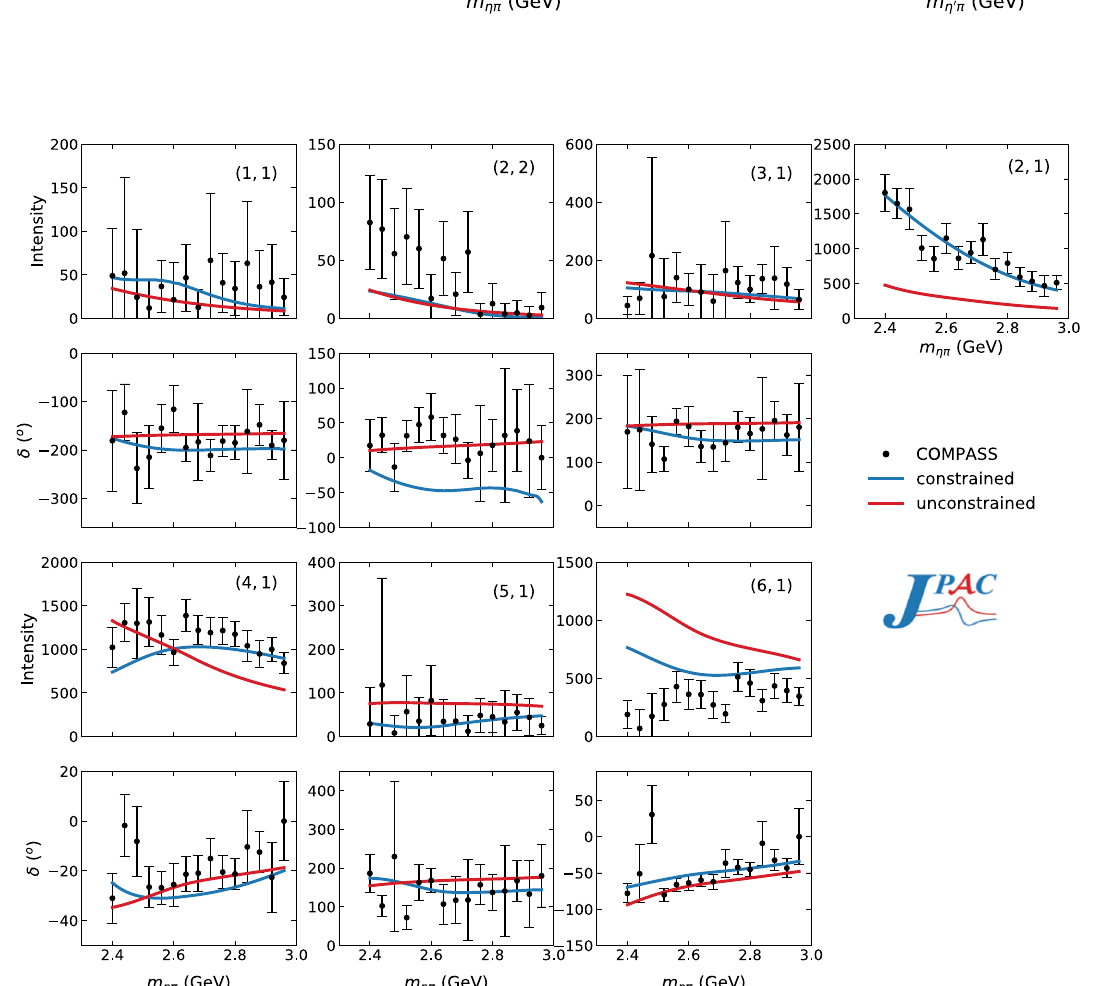
Fig. 23 Constrained (red) and unconstrained (blue) ηπ partial waves from Eqs. (18) and (16) for the MIN+ f 2 / IP , compared with the COMPASS data (black) . Partial waves intensities are labeled as ( L , M ) and the corresponding phases δ are presented below them. In this convention, δ 21 ≡